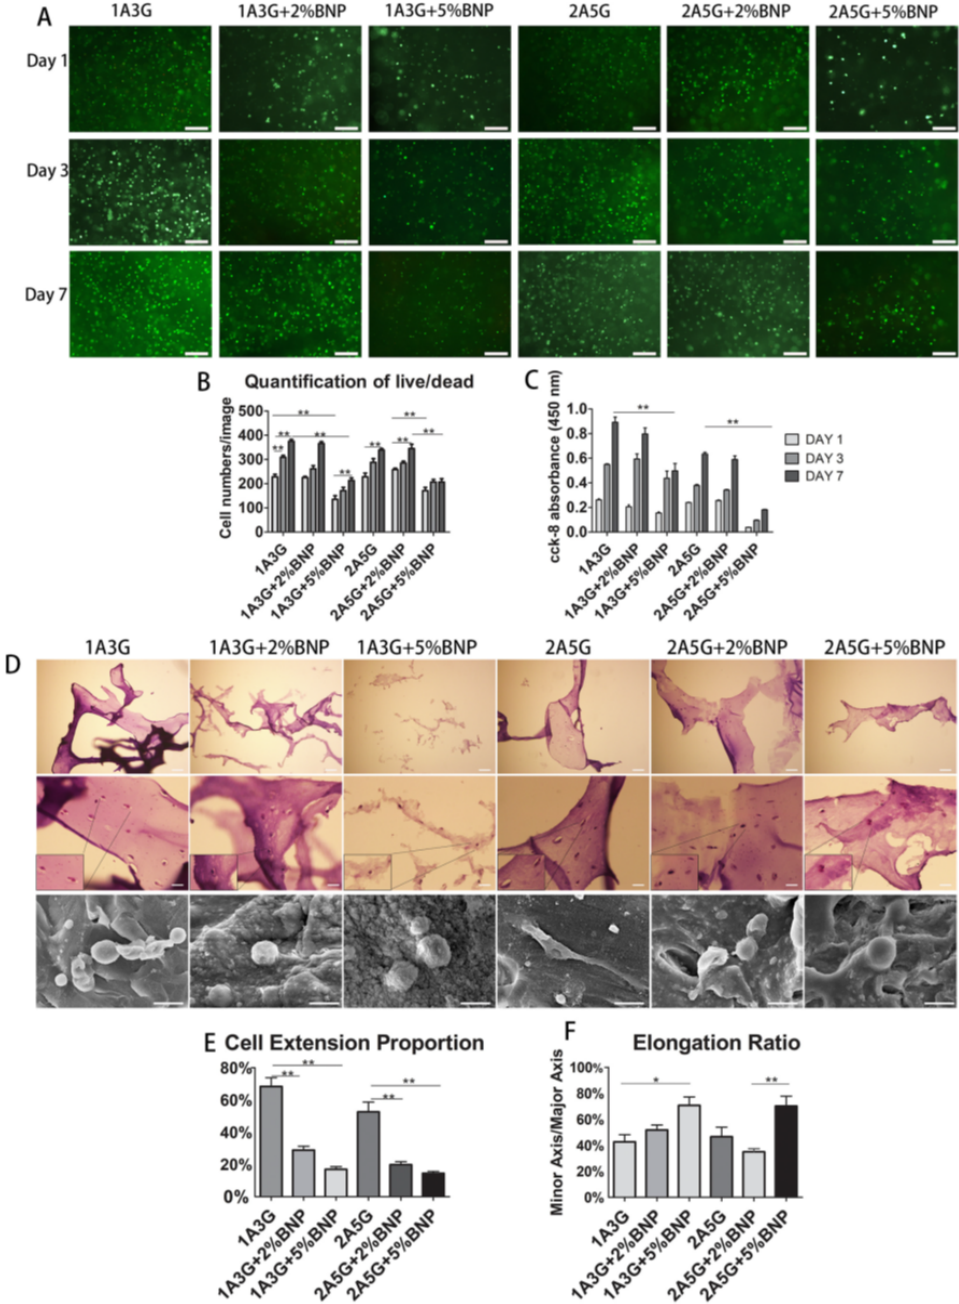
Figure 9. Cellular morphology of MSCs after treatment with different compositions of bioink. ( A ) Im- ages representing live/dead cells in each bioink treatment groups at day 1, 3, and 7. ( B ) Quantitative analysis of the number of live cells. ( C ) Absorbance value at OD 450 nm in the CCK-8 cell prolif- eration assay. ( D ) Hematoxylin and eosin staining images depicting MSC spreading phenomenon. ( E , F ) Quantitative analysis of cellular extension and cell aspect ratio of extended cells,